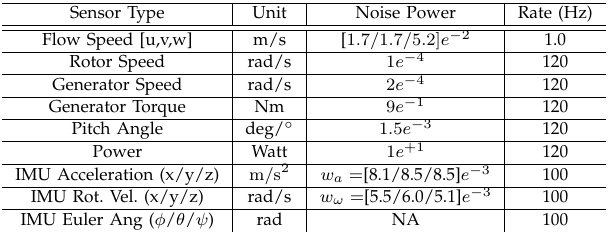
TABLE I S ENSOR CHARACTERISTICS FOR SIMULATED